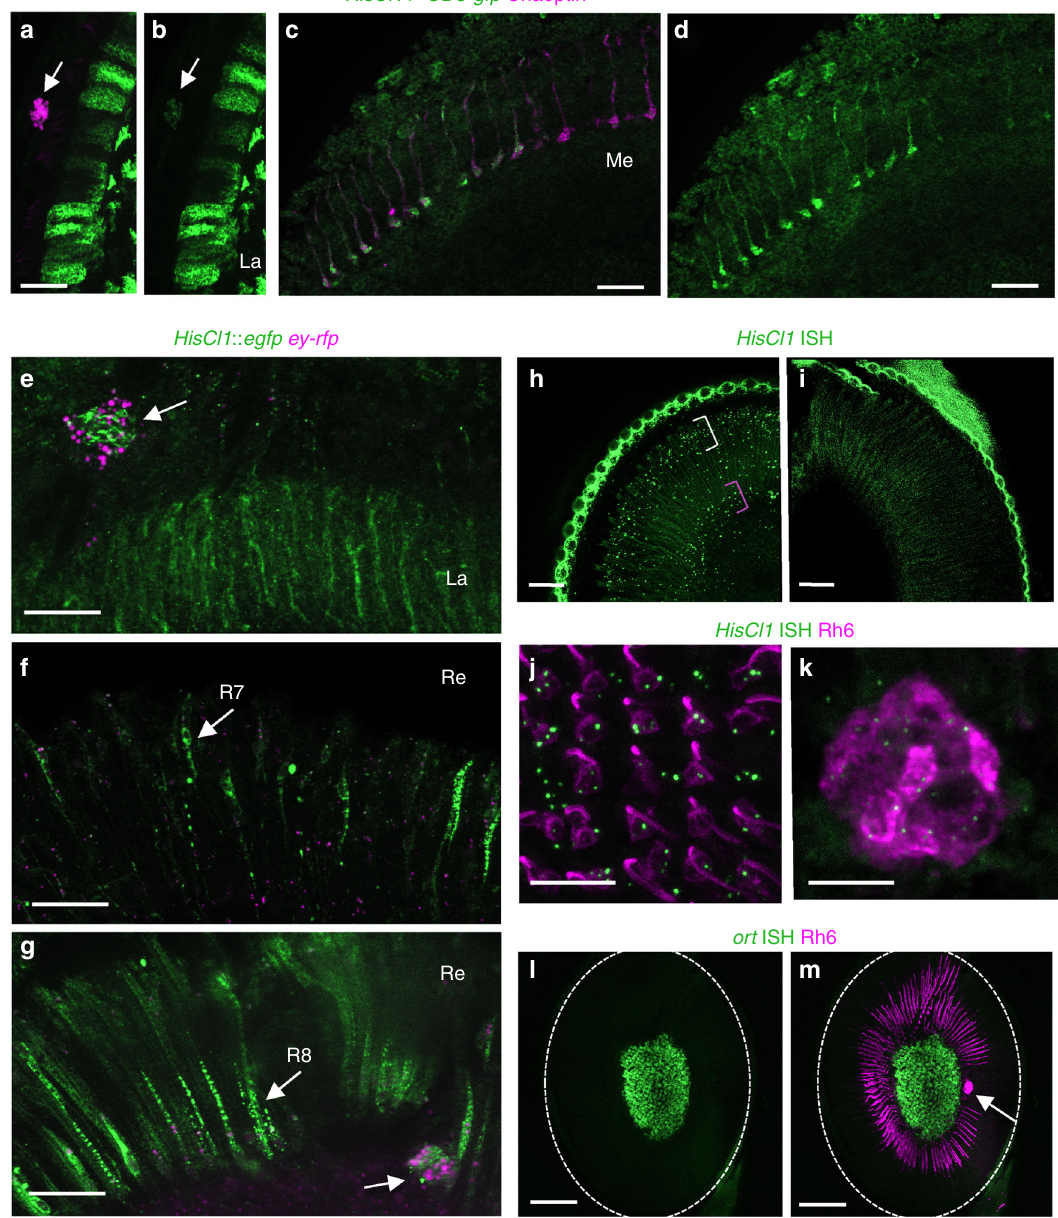
Fig. 3 HisCl1 but not Ort is expressed in photoreceptors. a – d Expression of HisCl1-gal4 UAS- mCD8-gfp , detected with anti-GFP antibody (green); photoreceptors are marked with anti-Chaoptin antibody (red). HisCl1 expression is detected in the lamina epithelial cells and very faintly in the eyelet ( a , b ). Weak labeling is observed in some R7 and R8 photoreceptors axons in the medulla ( c , d ). e – g Expression of GFP-tagged HisCl1 protein expressed from the HisCl1 promoter detected with anti-GFP antibody (green); photoreceptors are marked with ey- rfp from the same fosmid construct (red). HisCl1::GFP is detected in the lamina ( e ), H-B eyelet ( e , g ), and both in the R7 ( f ) and R8 ( g ) photoreceptors, identi fi ed by their respective position in the retina (arrows), upper layer for R7 and lower layer for R8. h – m HisCl1 ( h - k ) and ort ( l , m ) mRNA expression (blue) visualized by RNAscope ® in situ hybridization (ISH) (see Methods). Anti-Rh6 antibody (red) labels yR8 and eyelet photoreceptors in ( j , k , m ) . HisCl1 mRNA in the retina appears as puncta primarily in two layers: proximally, near the R8 photoreceptor nuclei ( h pink bracket) and distally, near the R1-7 photoreceptor and other retinal cell nuclei ( h yellow bracket). No puncta were detected in the HisCl1 134 mutant ( i ). In the R8 photoreceptor layer HisCl1 mRNA is expressed in the Rh6-positive (red) yR8 retinal photoreceptors, as well as in the surrounding cells that likely include Rh5-expressing pR8 photoreceptors ( j ). HisCl1 mRNA is also present in the Rh6- expressing H-B eyelet ( k ). ort mRNA is expressed in the lamina but not in the retina ( l , m ). In particular, ort is undetectable in the Rh6-expressing cells (red in m ) both in the retina (outlined in l , m ) and in the eyelet. In ( h , i ), the retinas are surrounded by the auto fl uorescent cuticle. Images in ( h – m ) are maximal projections of short confocal stacks (thickness: 10 ( h , i ), 12 ( j , k ), 13.5 ( l - m ) µ m). La lamina, Me medulla, Re retina. White arrows point to the H-B eyelet. Scale bars represent 20 ( a – i ), 10 ( j , k ), and 50 ( l , m ) µ